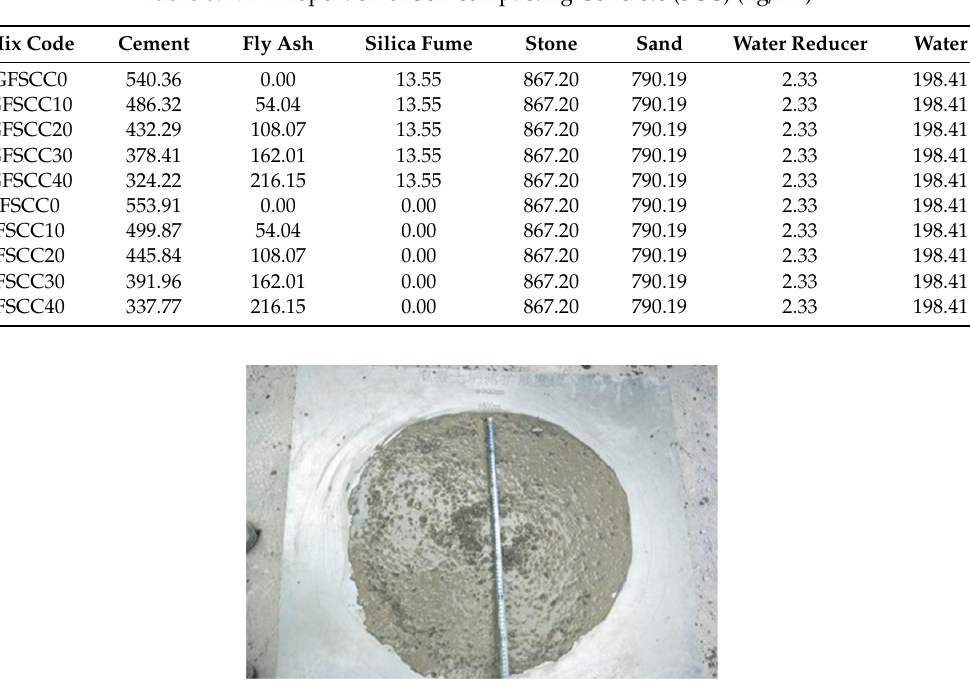
Table 6. Mix Proportion of Self-compacting Concrete (SCC) (kg / m 3 ).